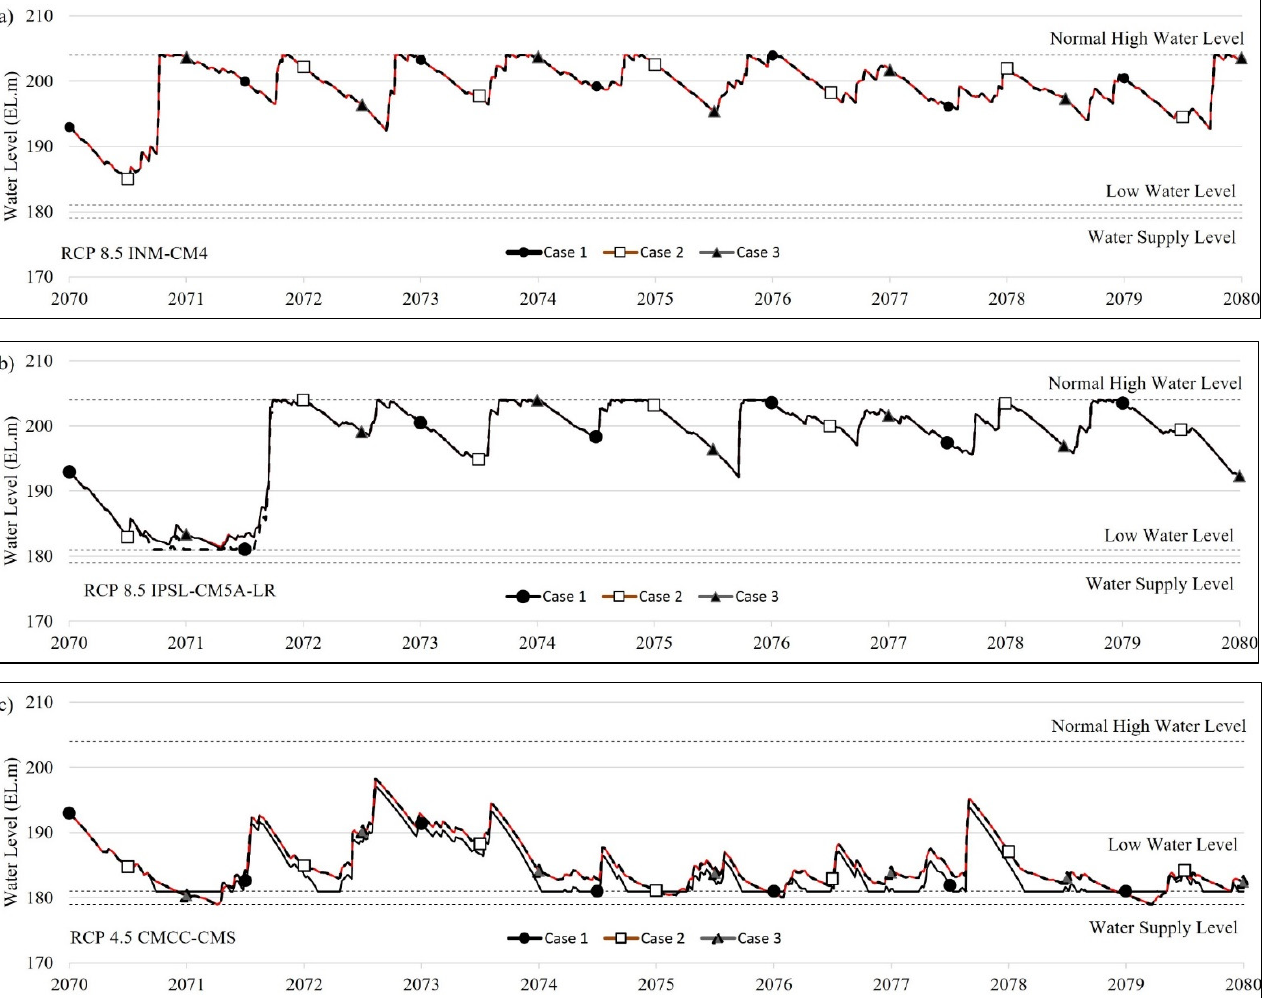
Figure 7. Changing water level in Hapcheon reservoir for Case 1, Case 2, and Case 3 in Scenario